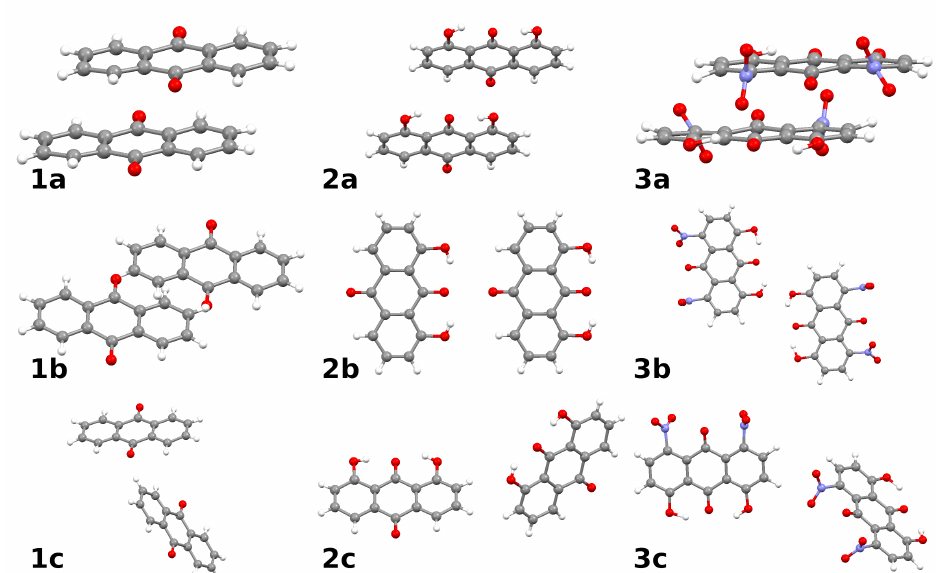
Figure 6. The structures of the dimers of compounds 1 , 2 , and 3 taken into account in the interaction energy study. Additional letter labels indicate: a —stacked dimers, b —head-to-head or head-to-tail structures, c —structures with C-H · · · O bonding. Atoms coloring scheme: grey—carbon, red—oxygen, blue—nitrogen,